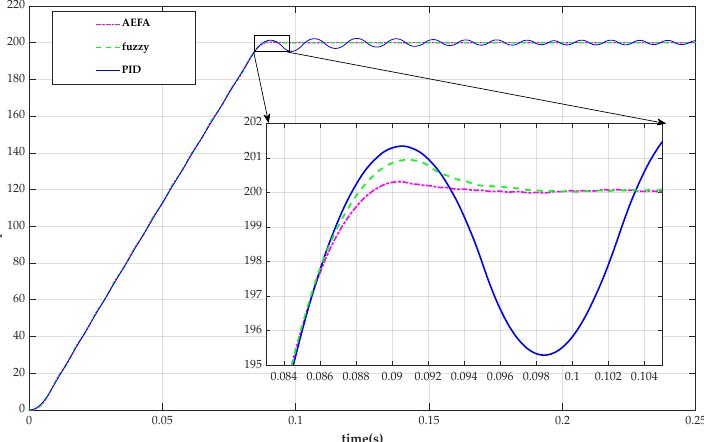
Figure 11. Speed response of BLDC motor for three controllers under no-load condition.